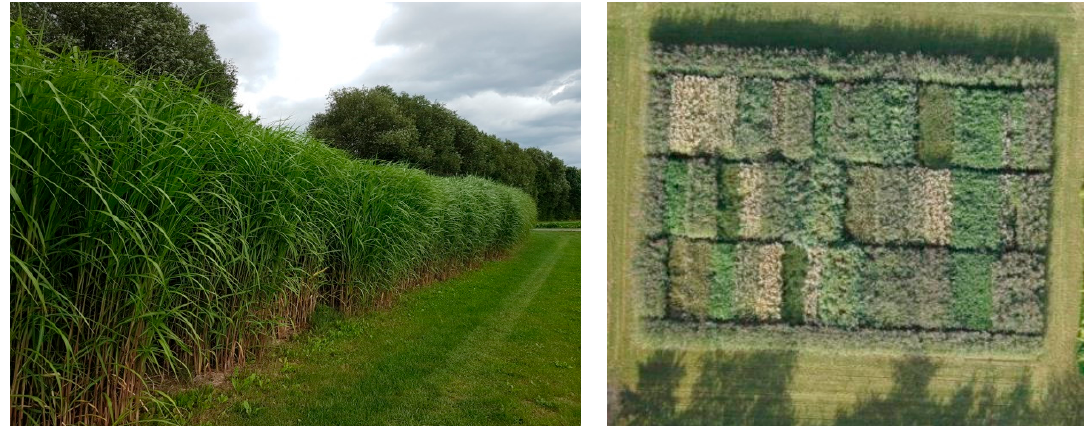
Figure 4. Miscanthus fields at the Campus Klein-Altendorf, Rheinbach, Germany. Left : Miscanthus x giganteus in spring time. Right : Color differences resulting from crops planted in different seasons; light colored parcels of dried crops versus darker fields of freshly planted crops. Copyright 2019, Katharina Walbrück.